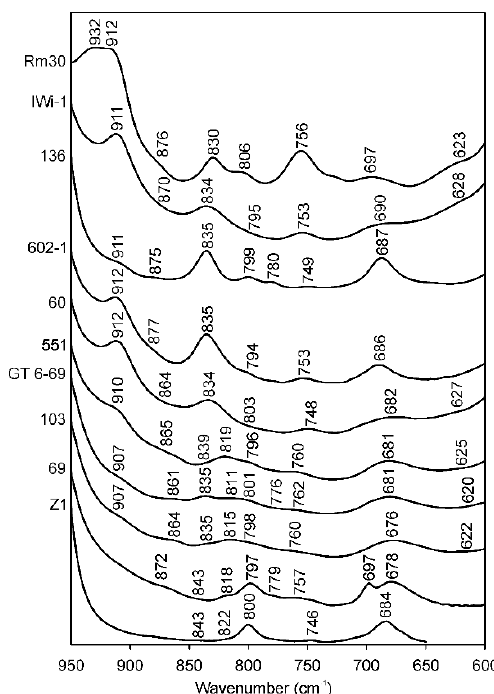
Figure 7. FTIR spectra of selected samples in the region of 950–600 cm − 1 . RM30—(Mg, Fe) ‐ poor illite; Iwi ‐ 1—Mg ‐ rich illite; 136—aliminoceladonite; 602 ‐ 1—aluminoceladonite; 60—Mg ‐ rich, Fe ‐ bearing illite; BSH11—Fe ‐ illite; 551—Al ‐ glauconite; GT6 ‐ 69 and 103—glauconites; 69—celadonite; Z1—celadonite.